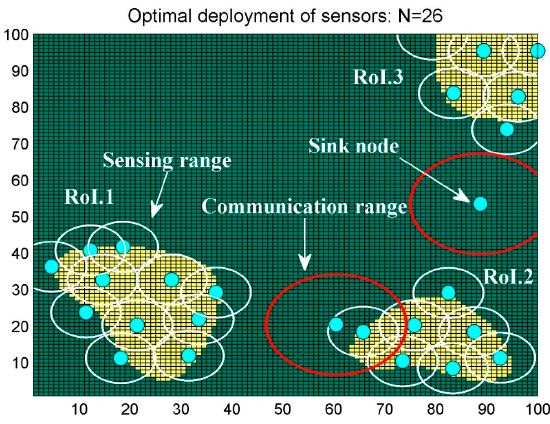
Figure 13. Optimal sensor deployment “Scenario 1”.